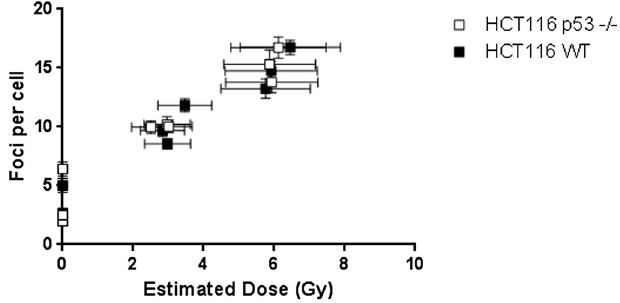
FIG. 9. Number of γ H 2 AX foci generated in HCT116 WT and p 53 − = − cells irradiated with an increasing dose provided by four or eight shots of laser-accelerated protons ( n ¼ 3 ). For each data point, foci were determined from at least 200